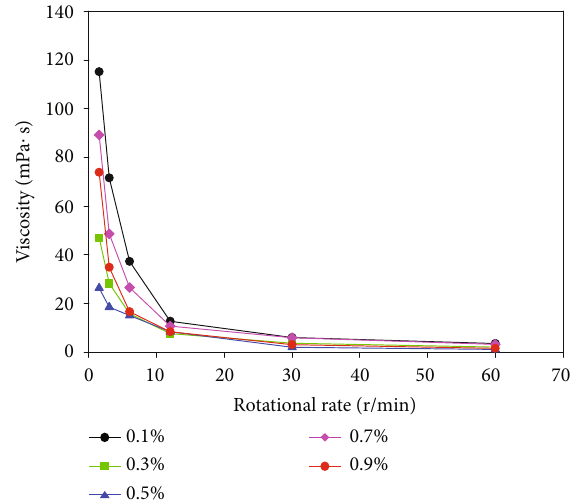
Figure 7: Relationship between the rotational rate and emulsion